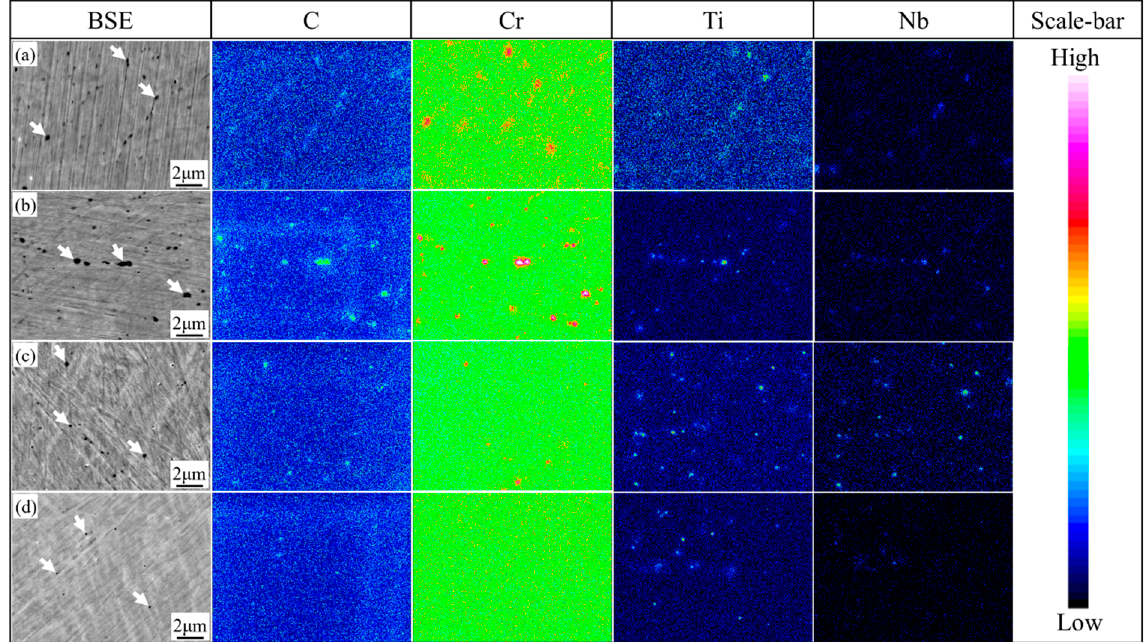
Figure 3. Alloying elements distribution maps of ( a ) 1000-Q; ( b ) 1020-Q; ( c ) 1040-Q; and ( d ) 1060-Q, where white arrows represent undissolved carbides and the scale bar indicates the concentration of each element.